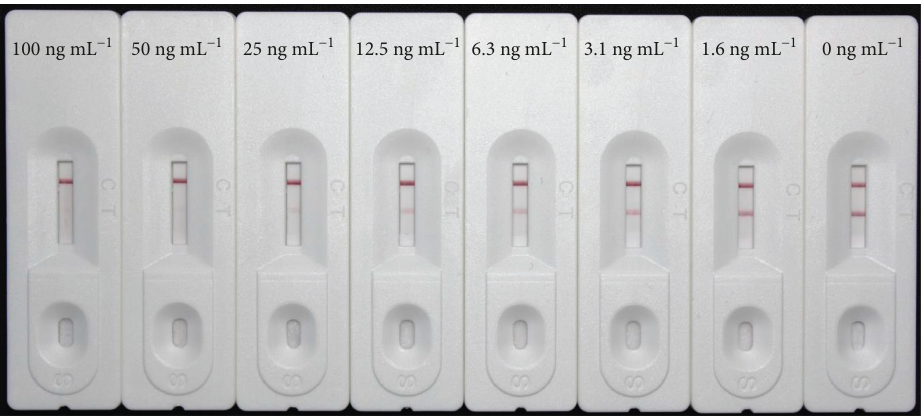
Figure 4: CGIC strips showing color changes corresponding to the concentrations of aloe-emodin. The cutoff value for aloe-emodin was 50ng mL − 1